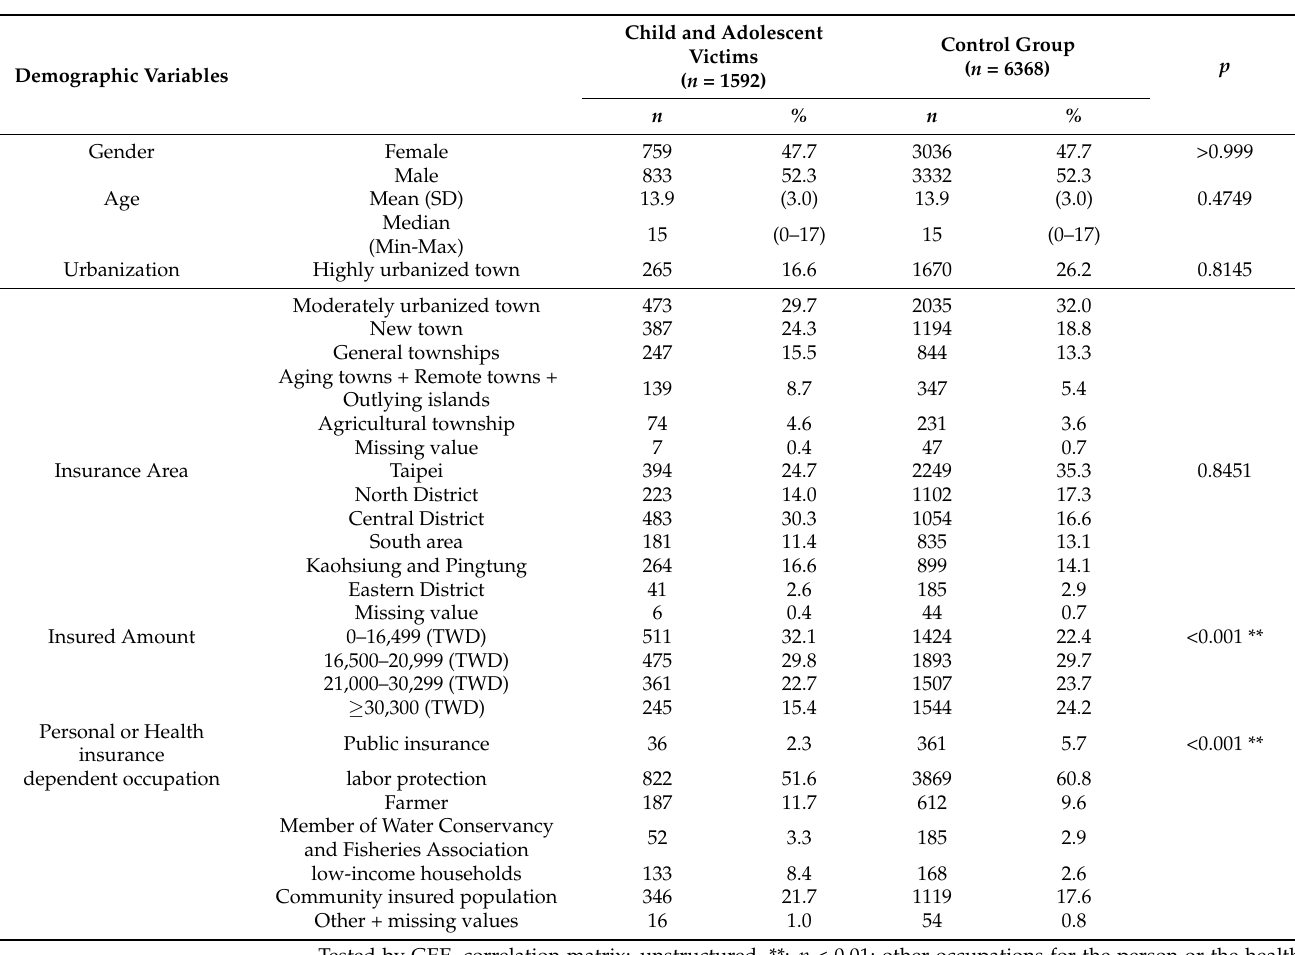
Table 1. Basic demographic data on medical treatment of children and adolescent victims and the control group.